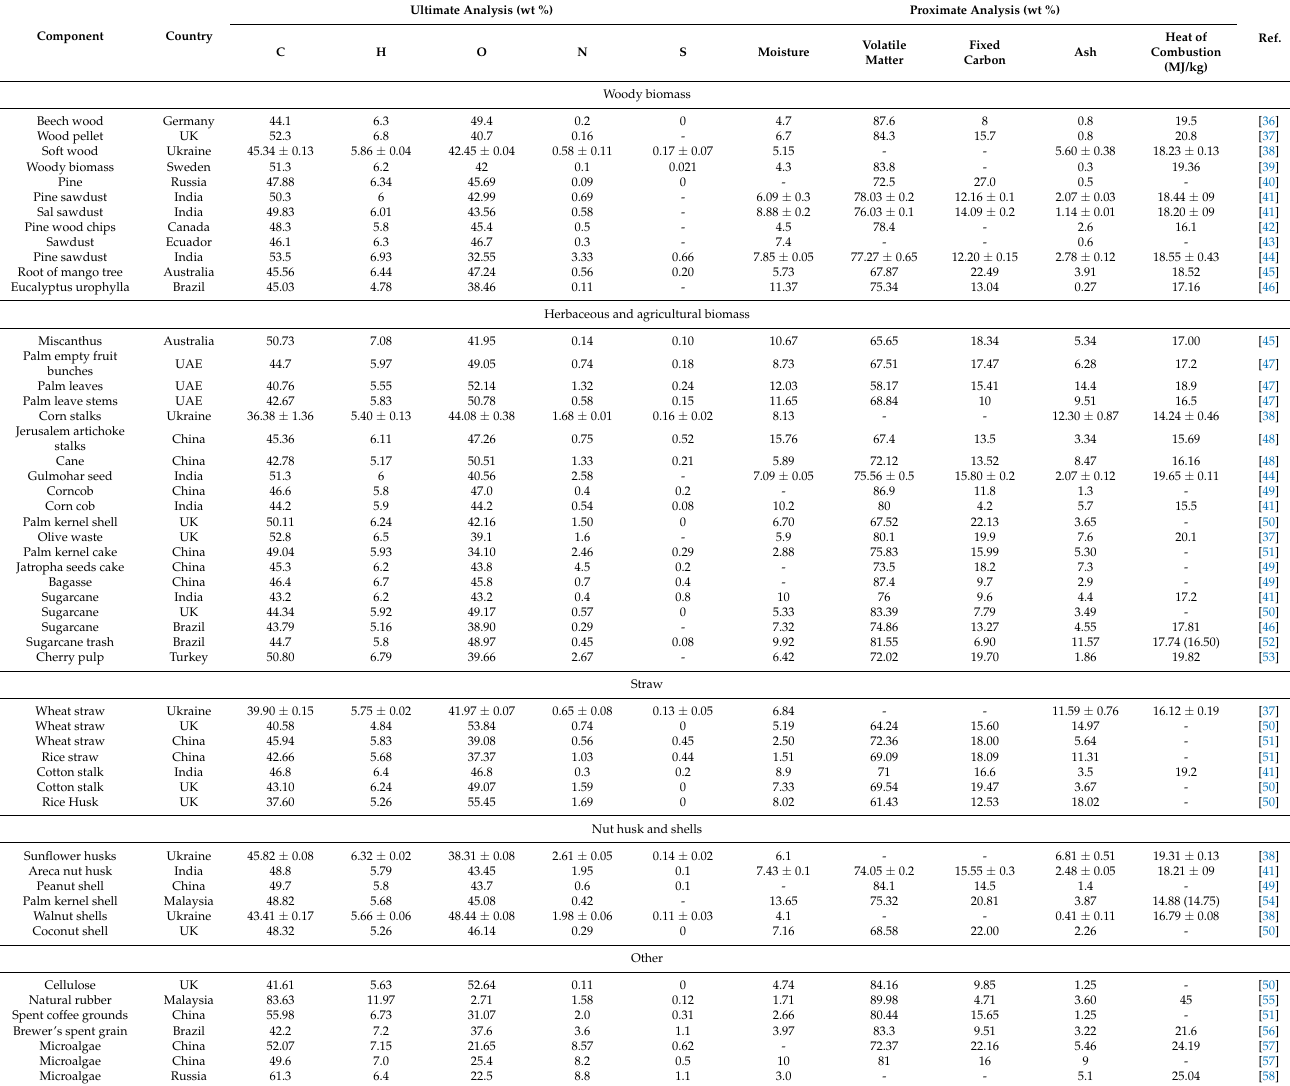
Table 4. Characteristics of components (type of biomass) used in gasification and